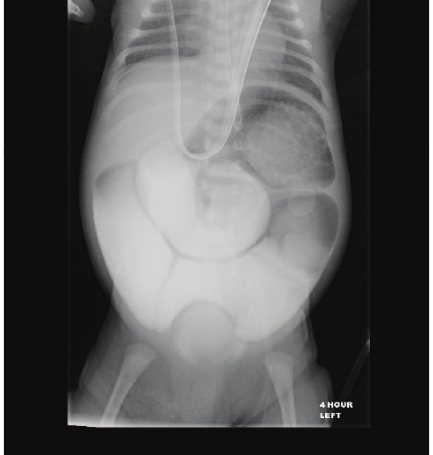
Figure 1: Upper gastrointestinal small bowel follow-through at 4 hours showing dilated loops of proximal small bowel and no progression of contrast through to the colon, suggestive of small bowel